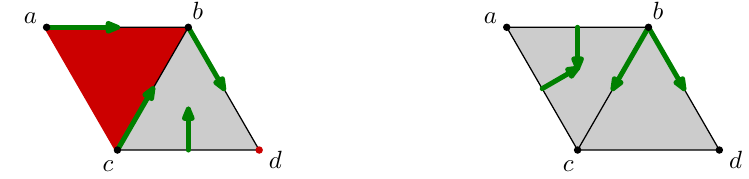
Figure 4. Discrete vector field on the right. On the left, the vectors do not form a